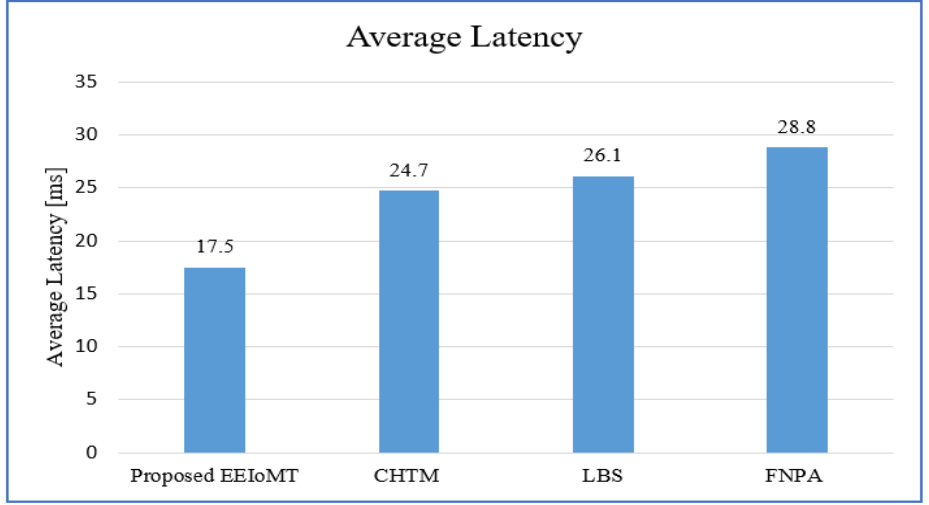
Figure 4. Comparison of Average Latency.